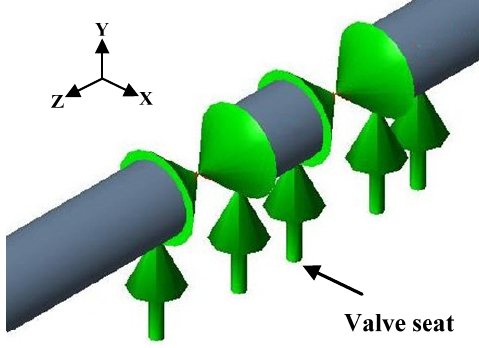
Figure 7. The model of valve seat.